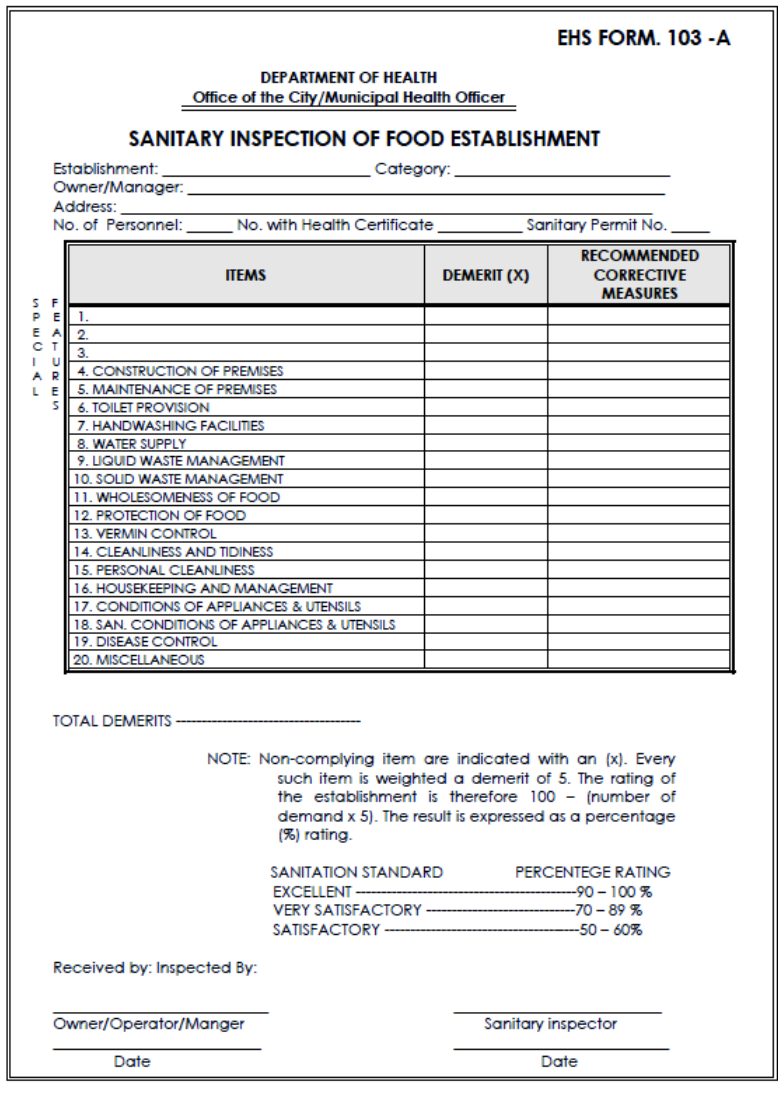
Figure 3. Sanitary Inspection of Food Establishment. Reprinted from the Department of Health’s manual [7].